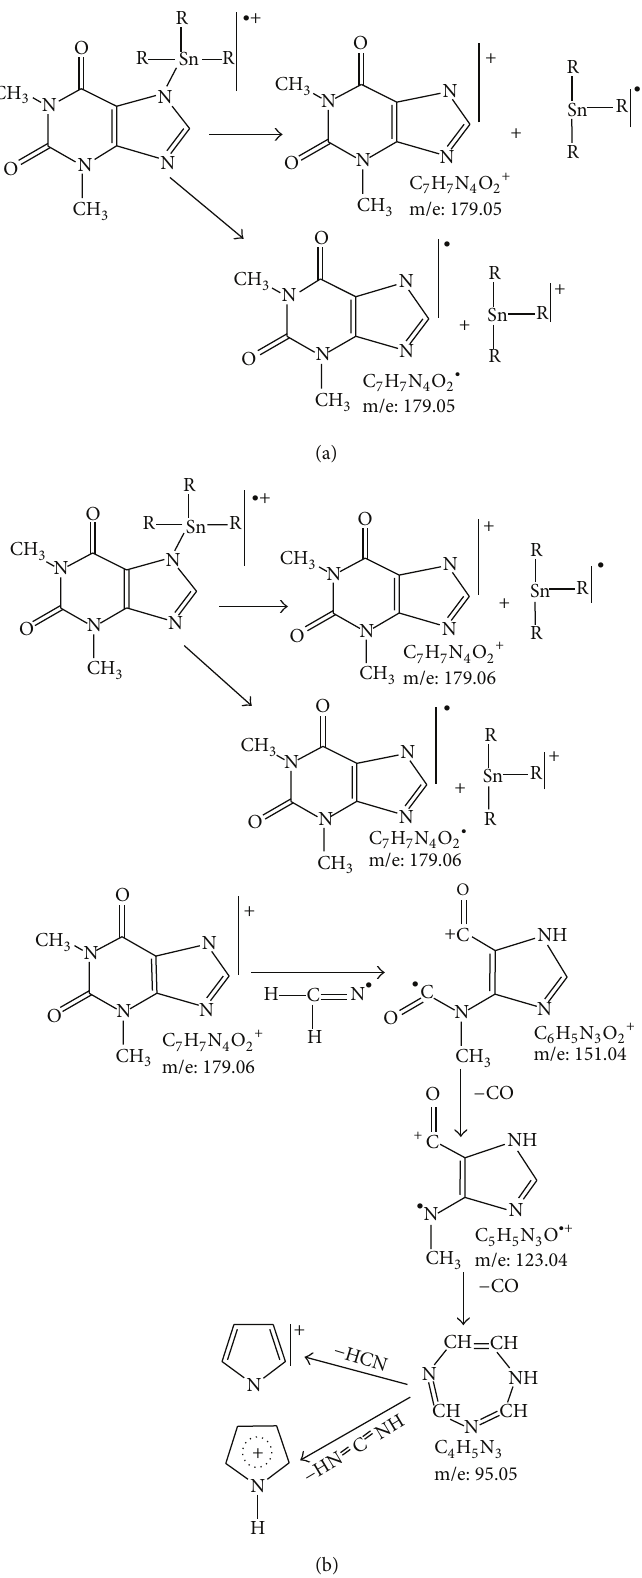
Scheme 1: Fragmentation pattern for theophylline